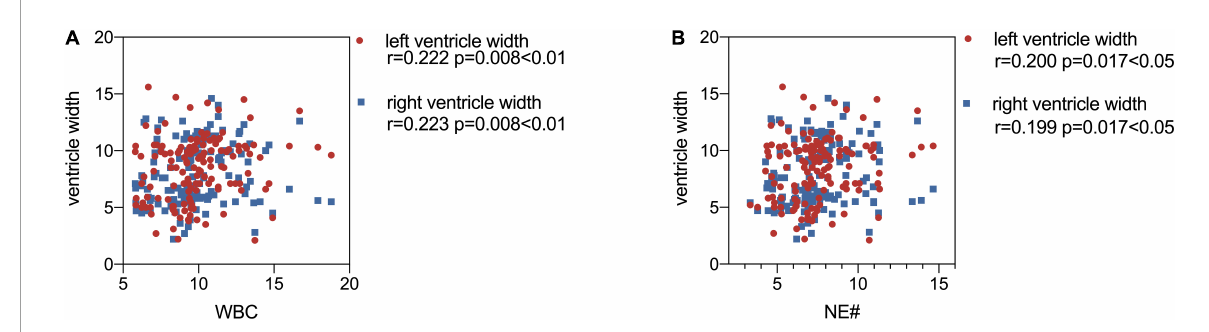
FIGURE4 Scatter plots show the correlations of maternal white blood cell (WBC) (A) , and NE# (B) with left/right ventricle width. WBC, white blood cell; NE#, neutrophil. P -values less than 0.05 were considered statistically significant.